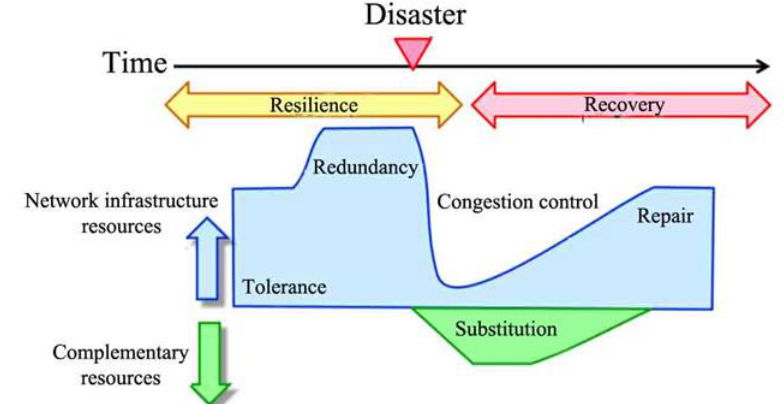
Fig. 2. Network recovery and flexibility